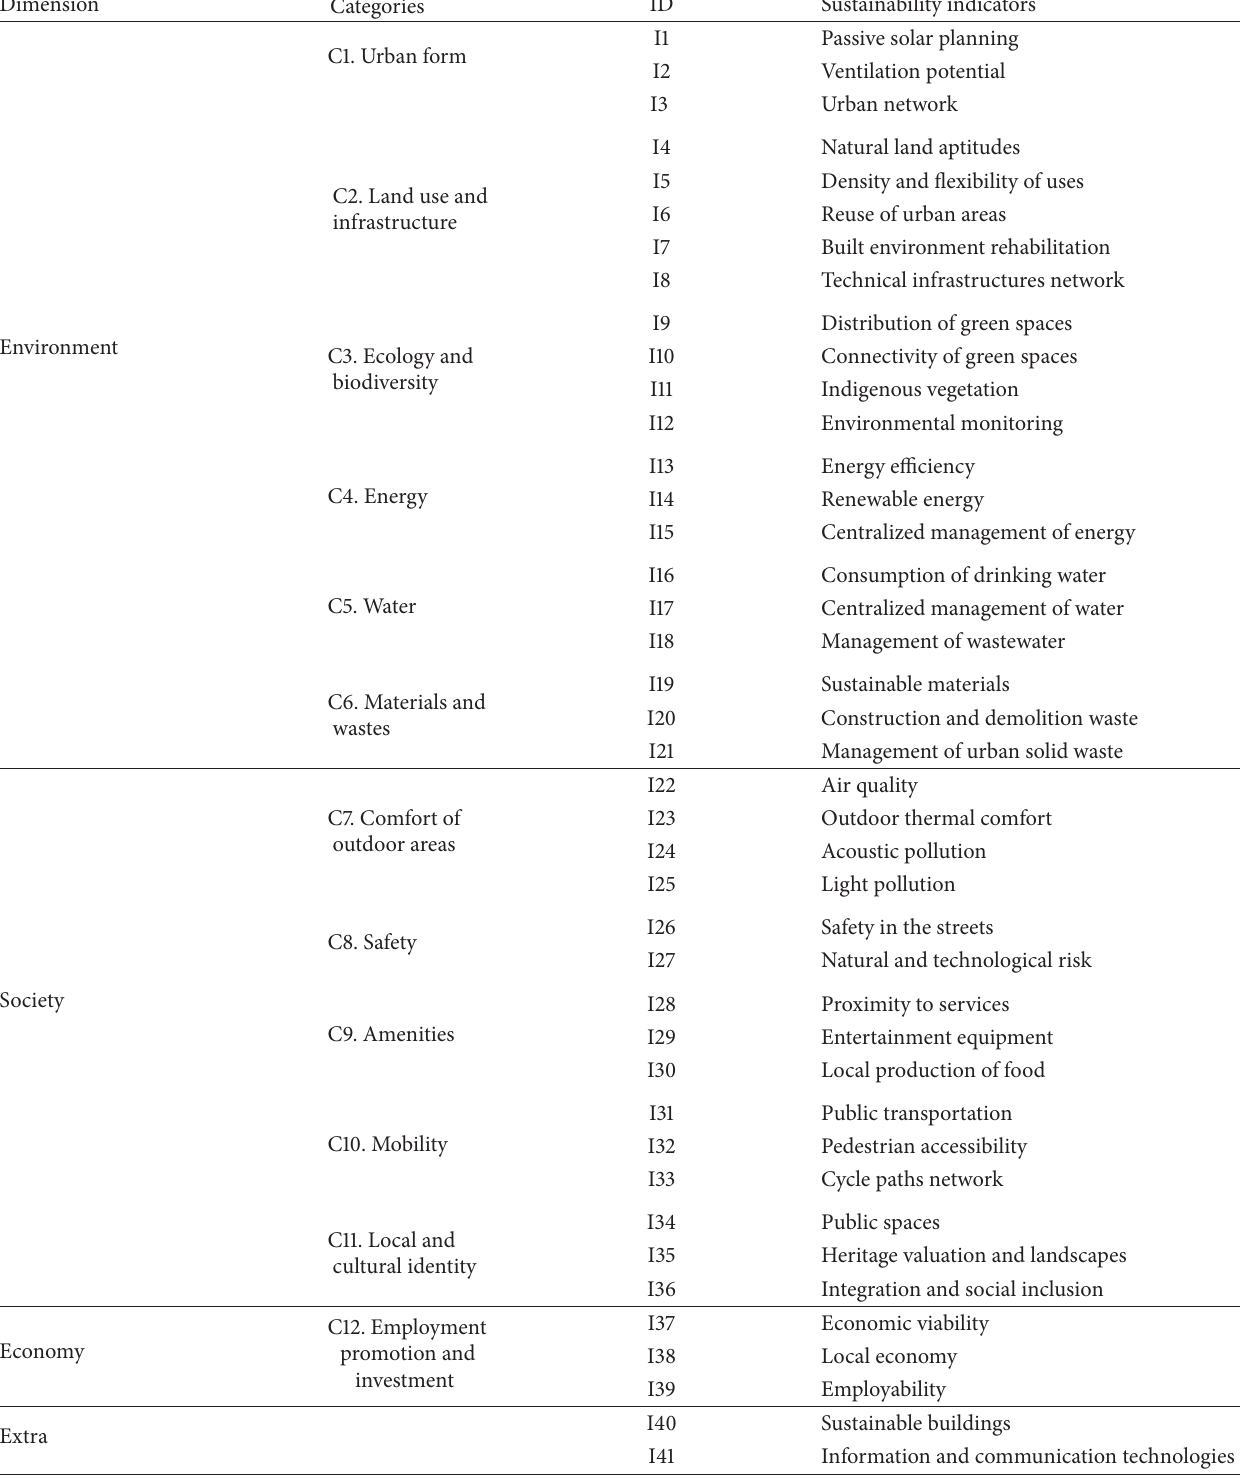
Table 1: List of categories and sustainability indicators for the SBTool PT -UP